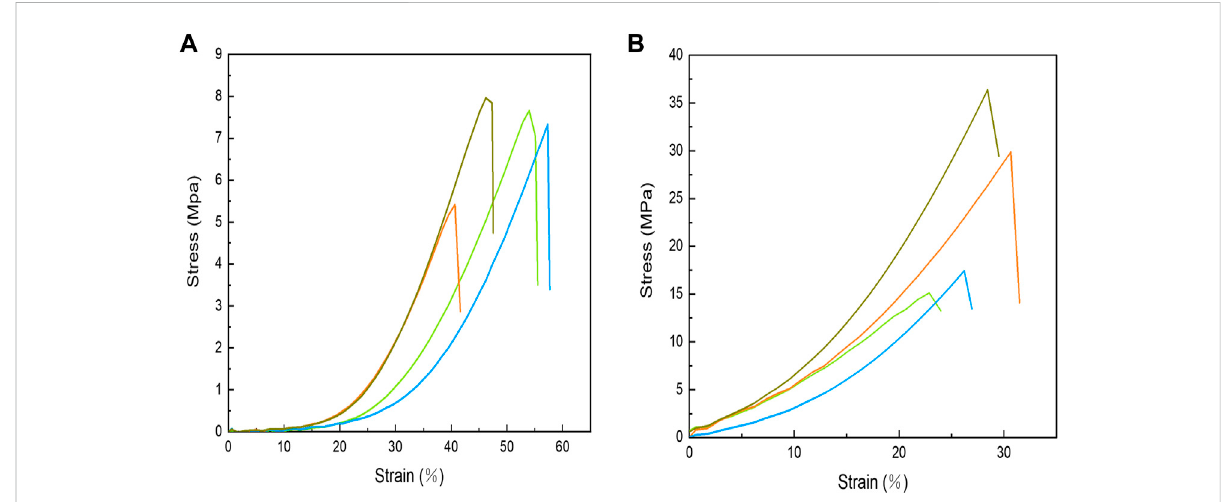
FIGURE 4 Stress-strain curves of uncross-linked (A) and EDC/NHS cross-linked (B) swimming